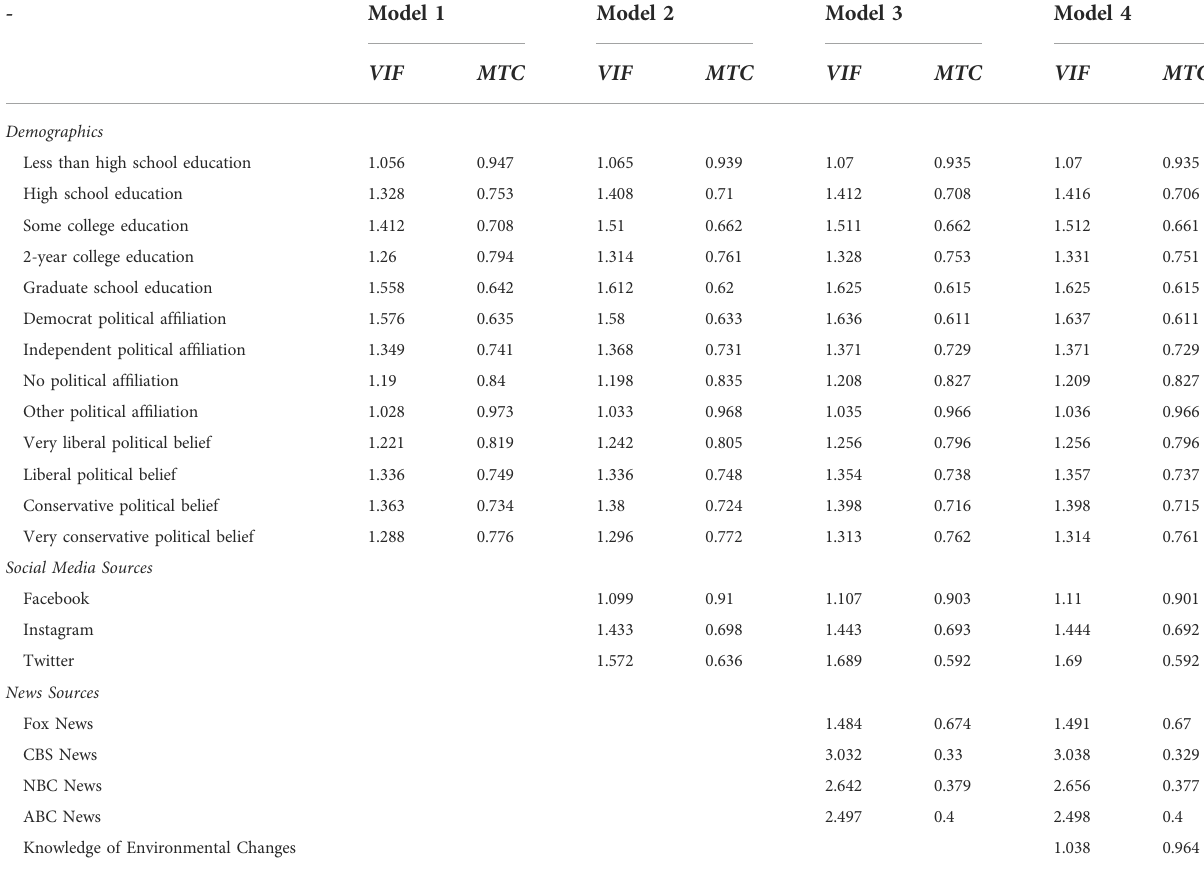
TABLE 5 Results of Variance of In fl ation Factor (VIF) and Multicollinearity Tolerance Coef fi cient (MTC) used to determine multicollinearity for environmental engagement intention regression analysis (N = 1,048).